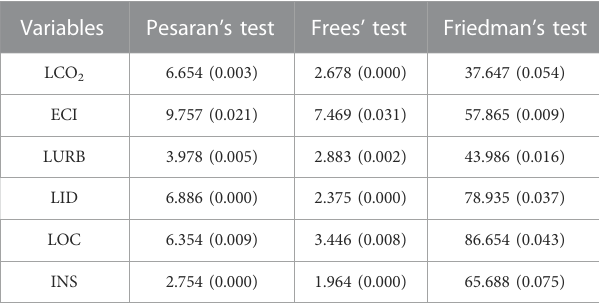
TABLE 3 Correlation matrix. Variables